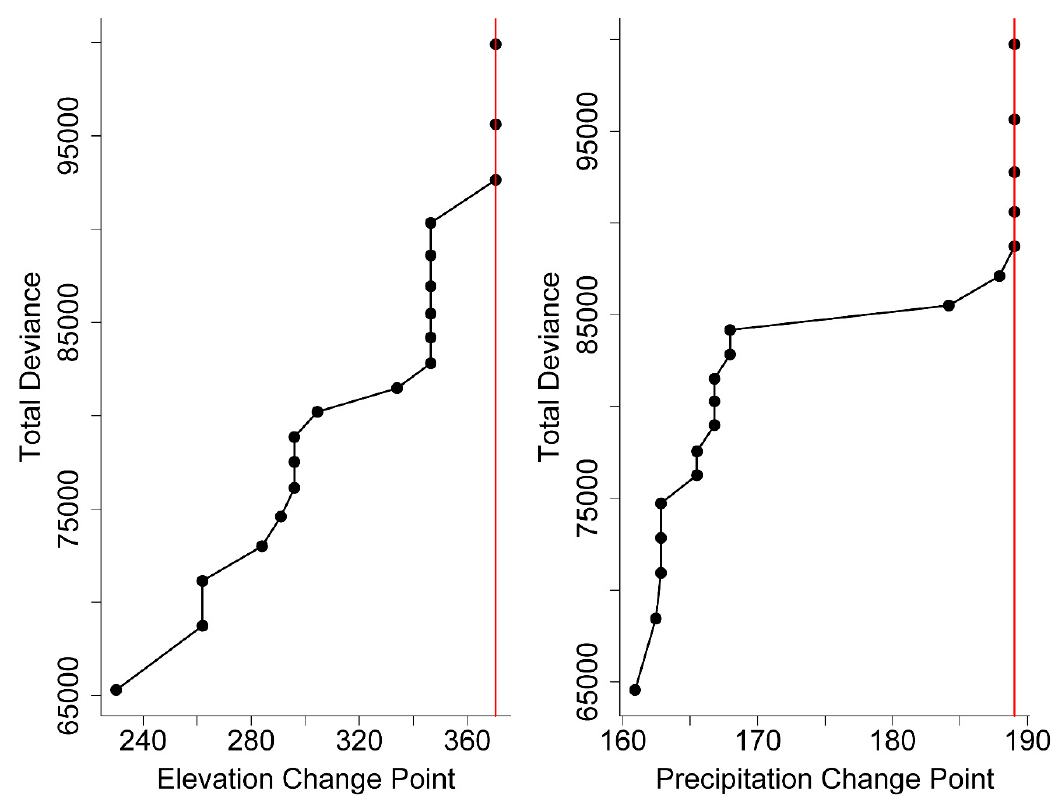
Figure A5. Plots of nonparametric changepoint analysis (nCPA) quantiles, showing the total deviance at each possible changepoint split. Each point is a quantile (every 5%) of the distribution of changepoints from the nCPA analysis bootstrap, with the exact changepoint value on the x -axis. The red line indicates the changepoint values selected for the segmented regressions on elevation and precipitation, respectively.